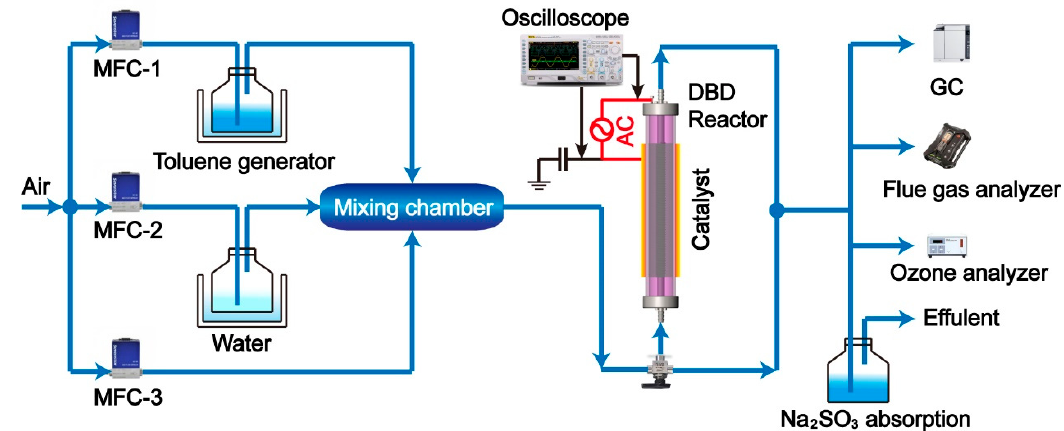
Figure 1. Schematic diagram of in plasma catalytic configurations for toluene decomposition.